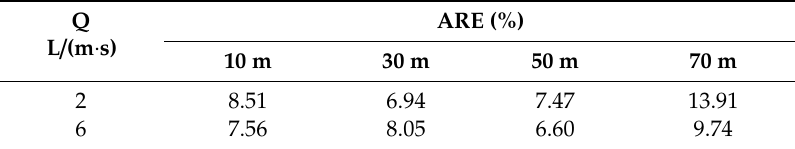
− Figure 7. Dynamic variation of SO 2 − concentration simulation values and measured results of surface Figure 7. Dynamic variation of SO 2 concentration simulation values and measured results of surface 4 4 water flow at different observation points under different inflow rates. water flow at di ff erent observation points under di ff erent inflow rates. Table 7. Absolute relative error (ARE) value under di ff erent basin inflow Table 7. Absolute relative error (ARE) value under different basin inflow rate.